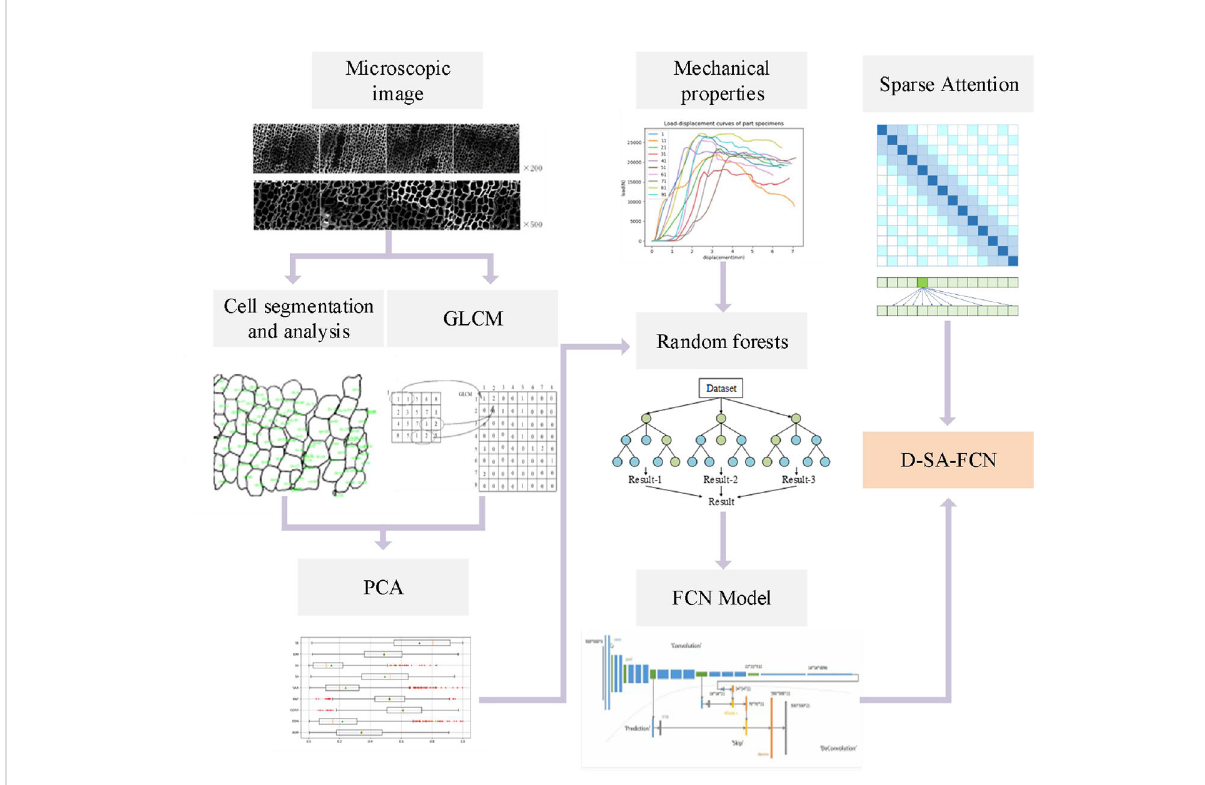
FIGURE 3 Method fl ow chart.